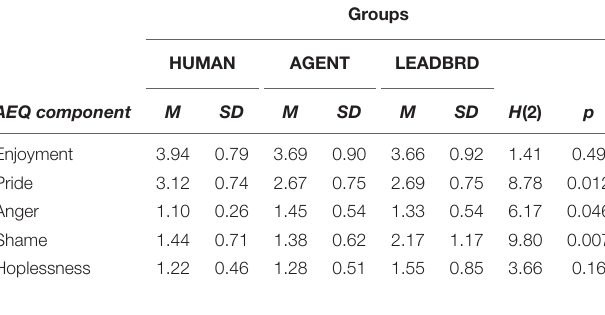
TABLE 2 | Social presence within the